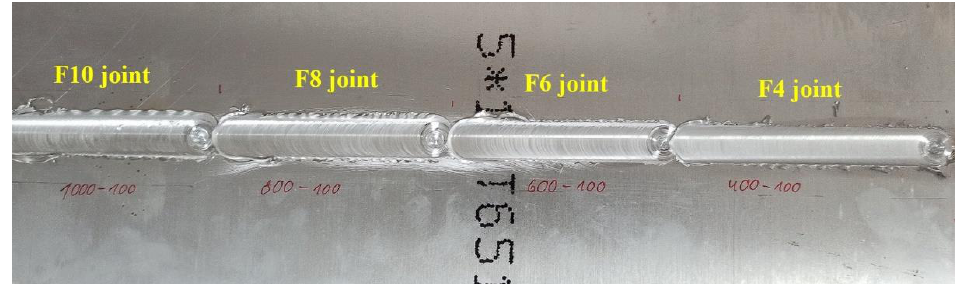
Figure 3. Example of welded joints obtained with 100 mm/min welding velocity.